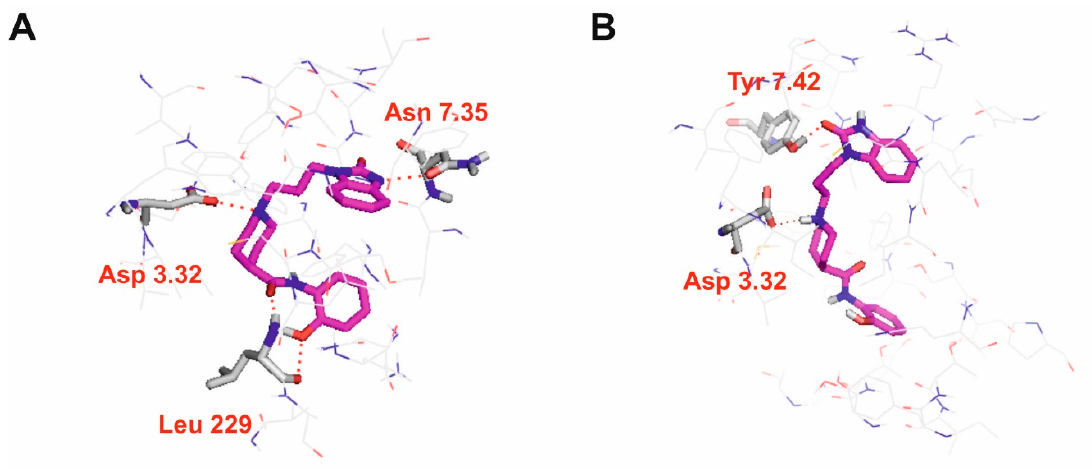
Figure 5. Molecular interactions of D2AAK4 with serotonin 5-HT 2A ( A ) and 5-HT 7 ( B ) receptors. Ligands are represented as sticks with magenta carbon atoms. Protein represented as wire with grey carbon atoms, main interacting residues, are shown as sticks. Hydrogen bonds are shown as red dashed lines. Nonpolar hydrogen atoms are not shown for clarity.